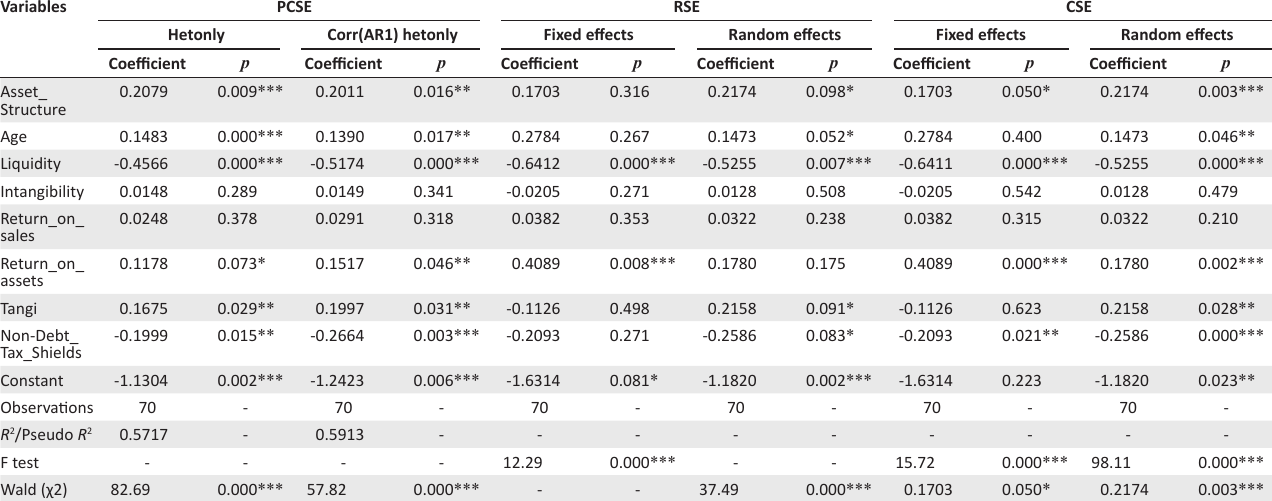
TABLE 3: Models with application of the robust standard error to random and fixed effects models